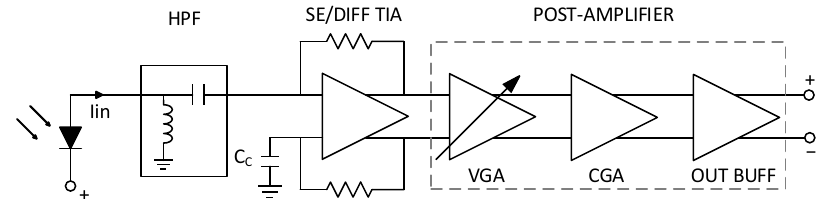
Figure 2. Functional block diagram of the proposed